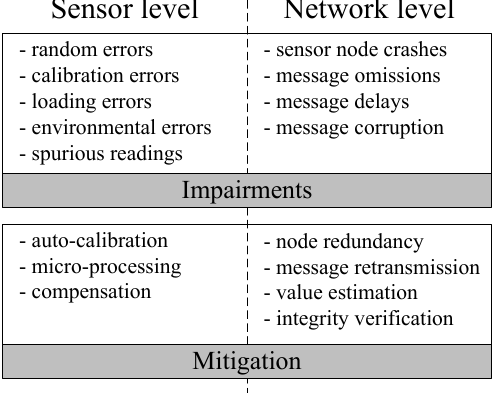
Figure 2. Sensor and WSN faults and mitigation